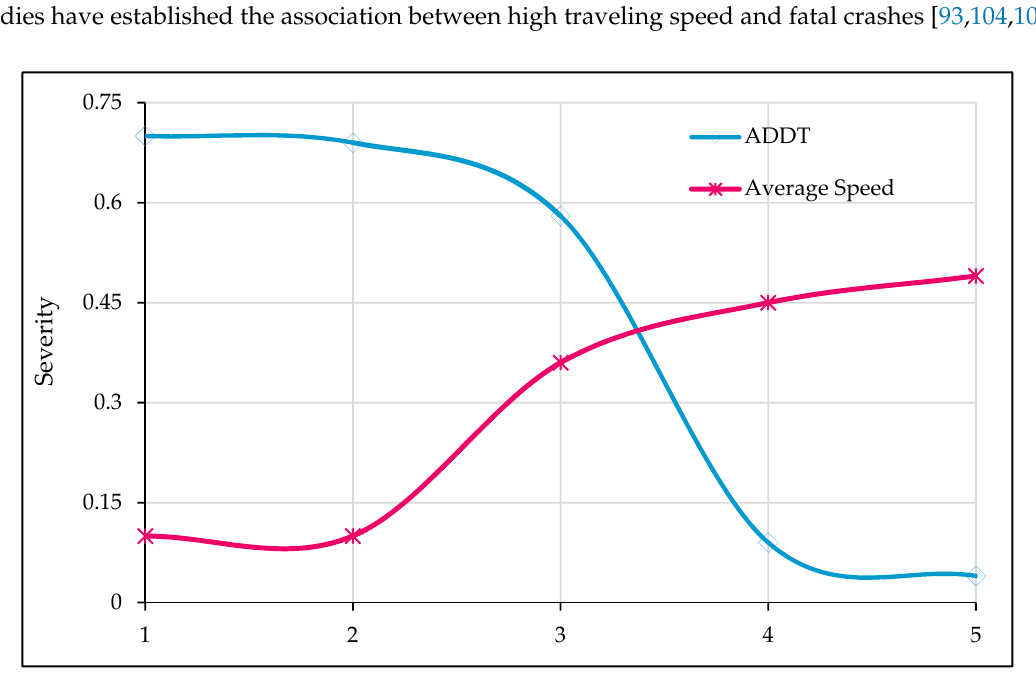
Figure 10. Effect of traffic characteristics on crash severity. Figure 10. E ff ect of tra ffi c characteristics on crash